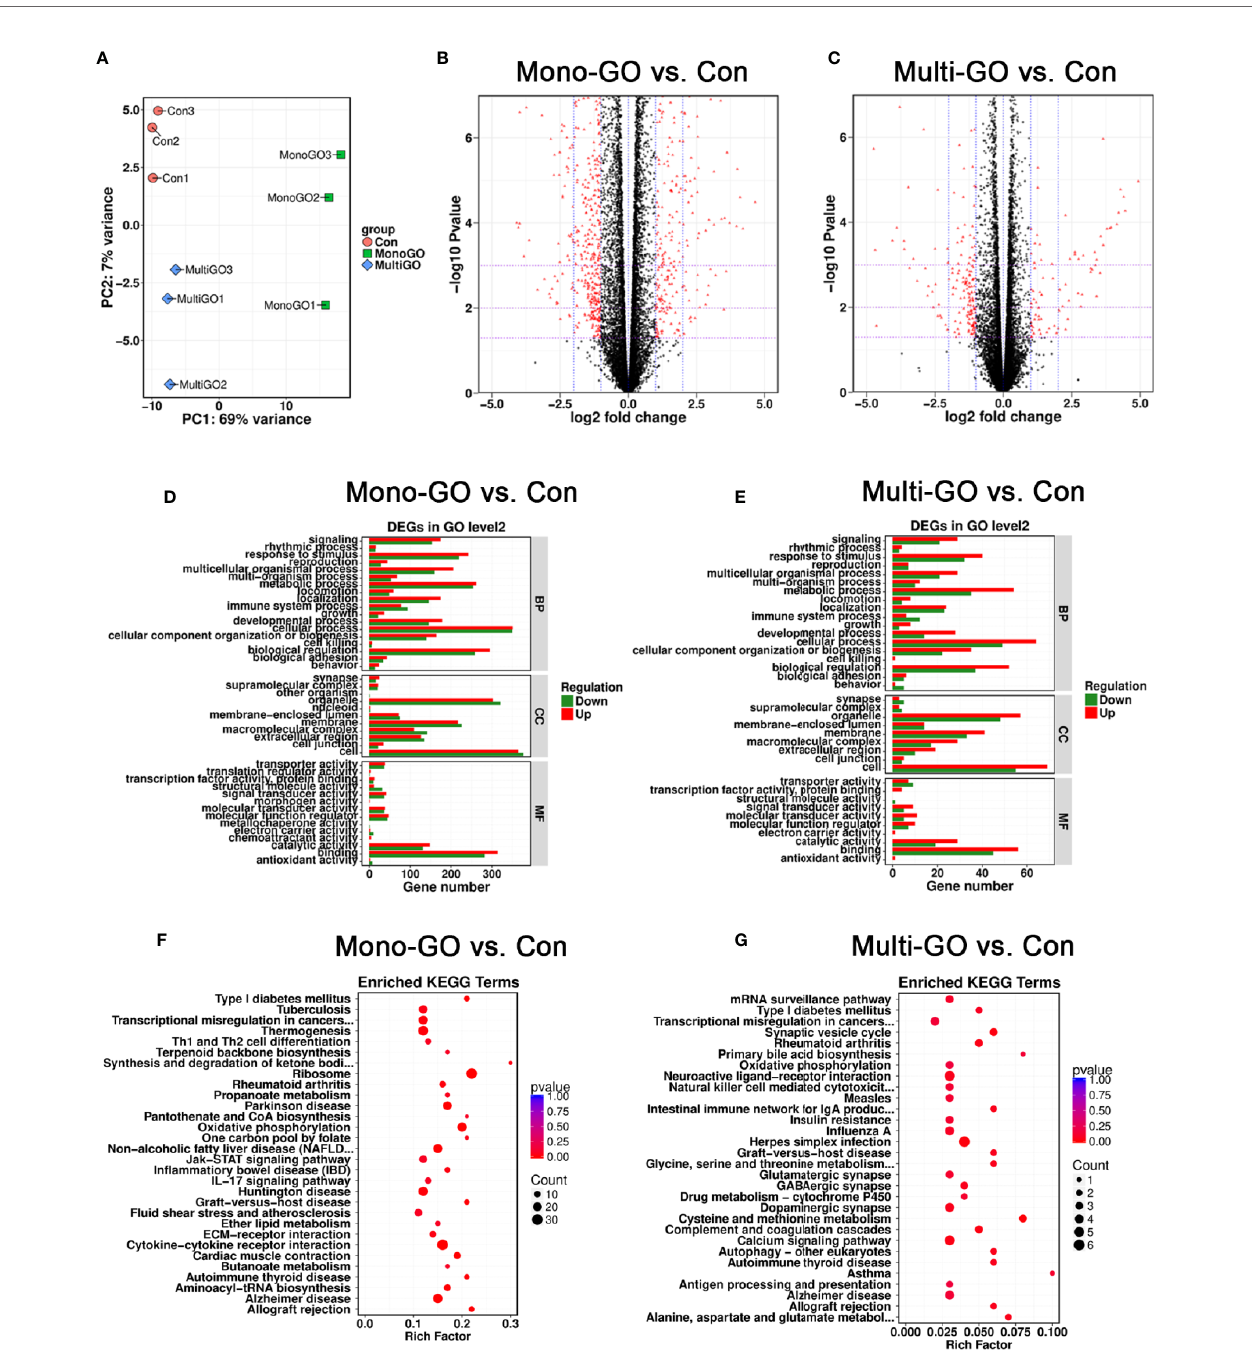
FIGURE 5 | (A) Principal component analysis (PCA) plots including all data, three groups [control, mono – graphene oxide (GO), multi-GO] and their biological replicates; control is in pink, mono-GO is in green and multi-GO is in blue. (B, C) The volcano map shows that all differentially expressed genes compared to the control group after treatment of DC2.4 cells with mono-GO and multi-GO. (P< 0.05, log 2 fold change > 1 or log 2 fold change < -1). (D, E) DC2.4 cells were analyzed for Gene Ontology (GO) enrichment at level 2 after mono-GO and multi-GO treatments. (F, G) DC2.4 cells were analyzed for KEGG pathway after mono-GO and multi-GO